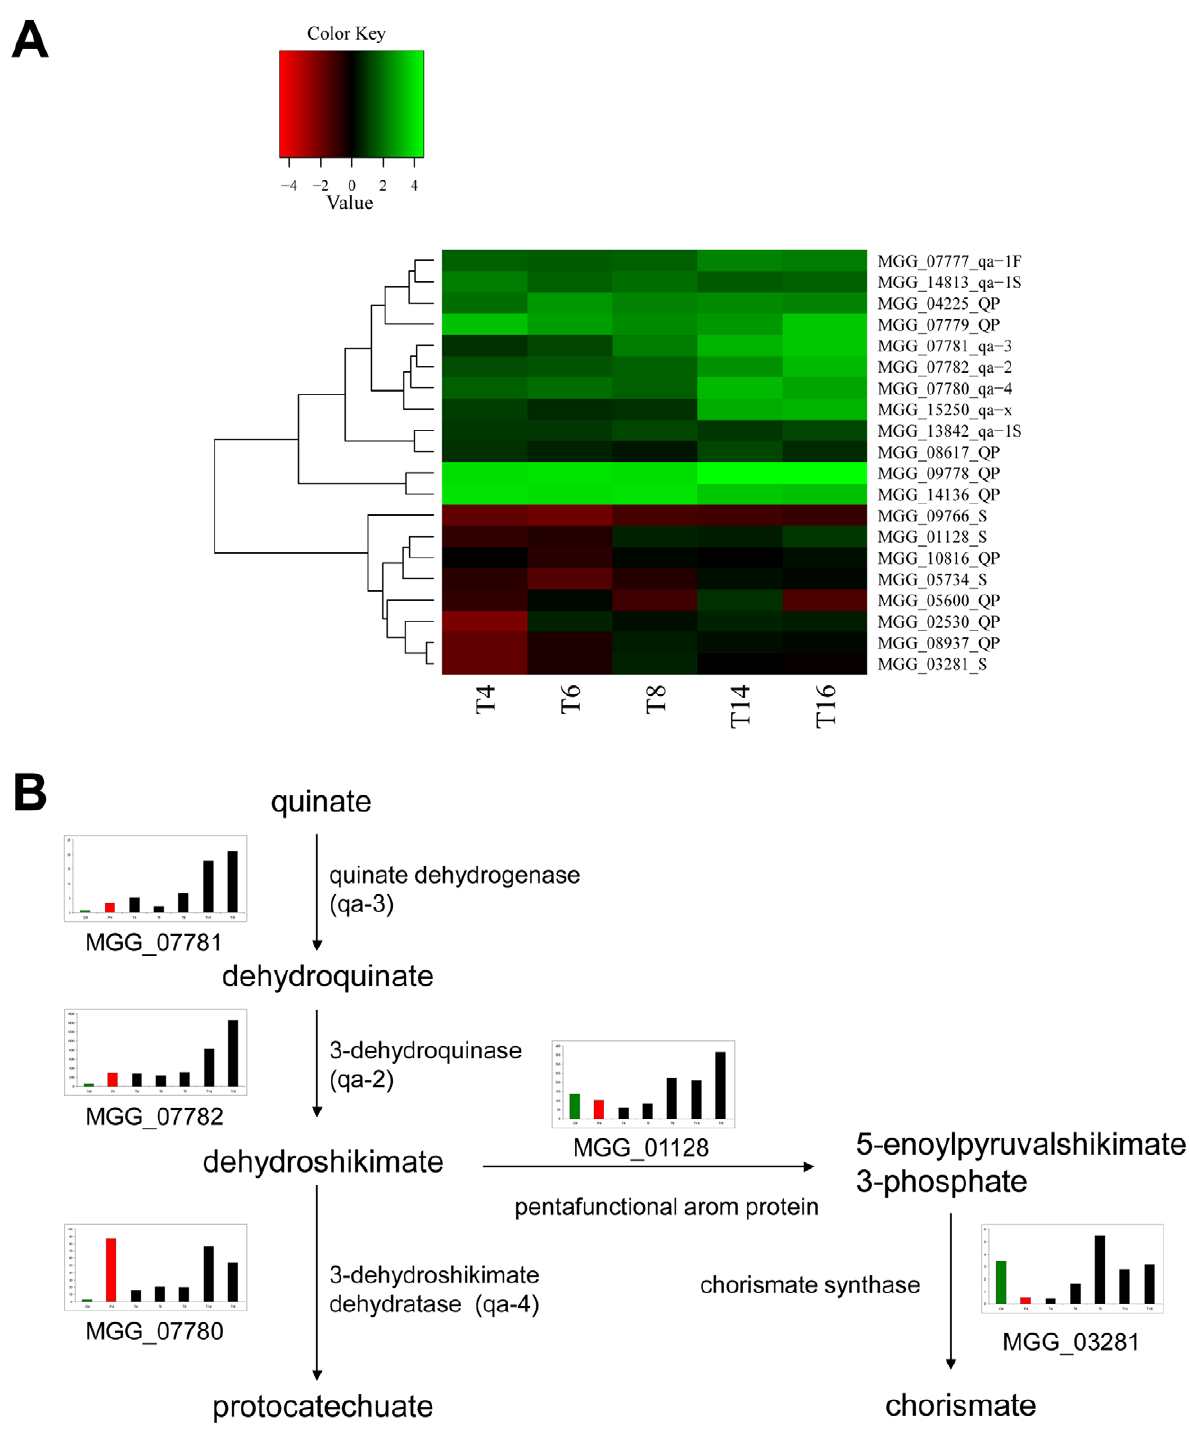
Figure 5. Levels of transcript abundance from genes involved in quinate metabolism. A . Heatmap showing levels of transcript abundance during time course of appressorium development. Levels of expression are represented as moderated log 2 ratio of transcript abundance as compared to mycelium grown in complete medium. Values are from 4 h (T4) to 16 h (T16) after conidia were incubated on a hydrophobic surface. Genes showing similar patterns of gene expression have been clustered. Homologues of genes involved in quinate metabolism in Neurospora crassa are labelled: quinate activator (qa-1F), quinate repressor (qa-1S), 3-dehydroquinase (qa-2), Quinate dehydrogenase (qa-3), 3-dehydroshikimate dehydratase (qa-4), function unknown (qa-x), quinate permeases (QP), shikimate pathway (S). B . Expression of genes involved in quinate metabolism. For each enzyme, bar graphs show abundance of transcripts encoding the gene in: Guy11 mycelium grown in complete medium (green bar), D pmk1 mutant conidia left to germinate for 4 h (red bar), a Guy11 time course of appressorium development (4 h, 6 h, 8 h, 14 h, 16 h – black bars left to right).